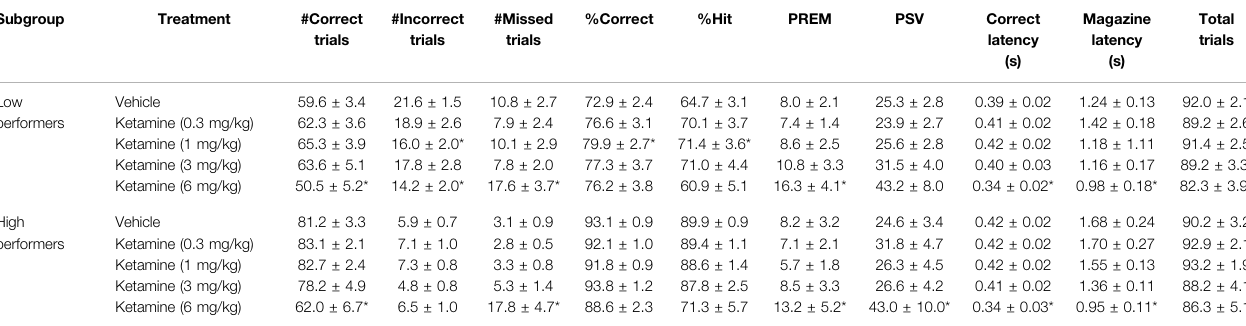
TABLE3| Performancemeasuresfrom5-choiceserialreactiontimetask:Standardconditionsof0.75 sSD,5 sITI,100trials.Ketamine “ low ” and “ high ” performers(N (cid:1) 12 per subgroup). Subgroup Treatment #Correct